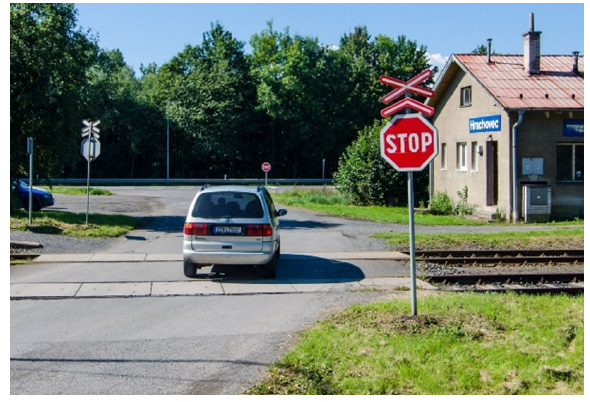
Figure 3. RC secured by warning crosses [ idnes.cz ].